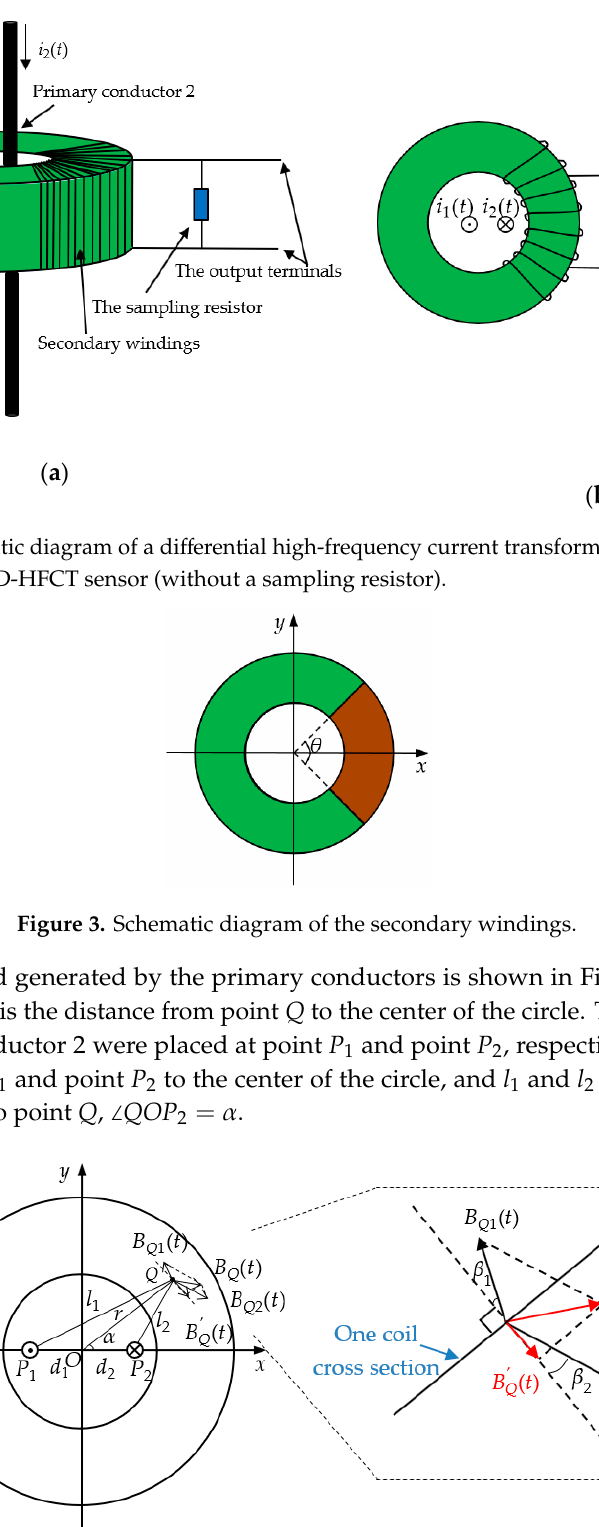
Figure 4. Magnetic field generated by primary conductors.